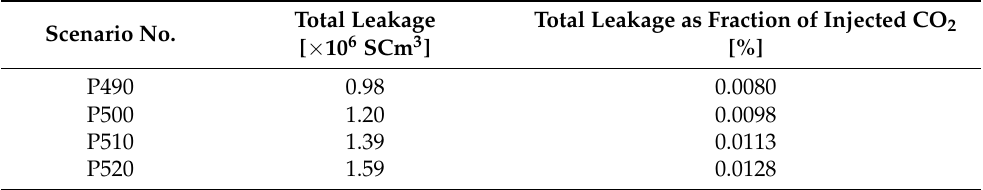
Table 9. Total leakage of CO 2 to the caprock.